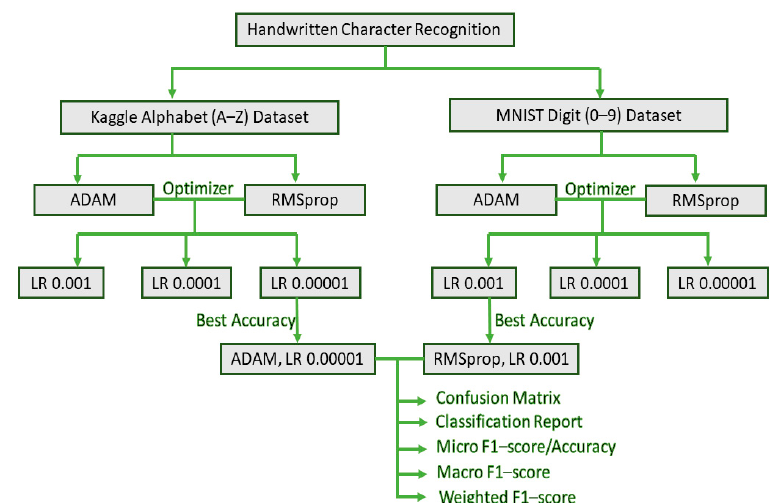
Figure 7. Best model selection from the Kaggle and MNIST datasets.